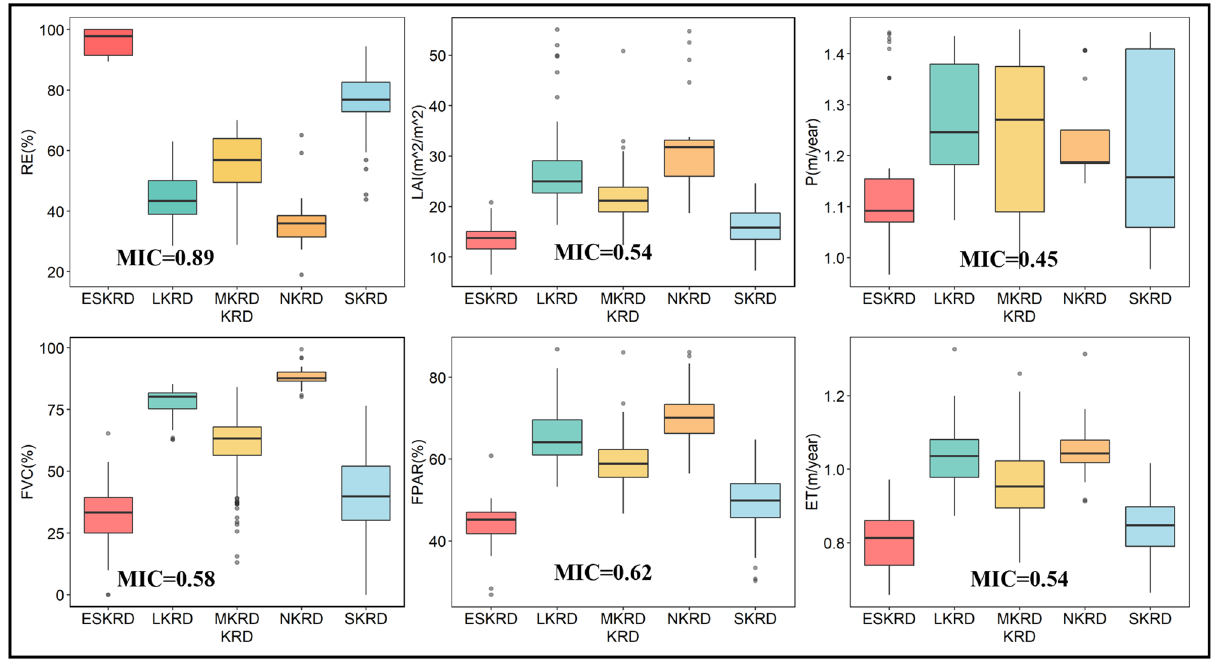
Figure 1. Feature factors of KRD in 2020 selected based on MIC. Abbreviations: NKRD—No karst rocky desertification. LKRD—Light karst rocky desertification. MKRD—Medium karst rocky desertification. SKRD— Severe karst rocky desertification. ESKRD—Extremely severe rocky